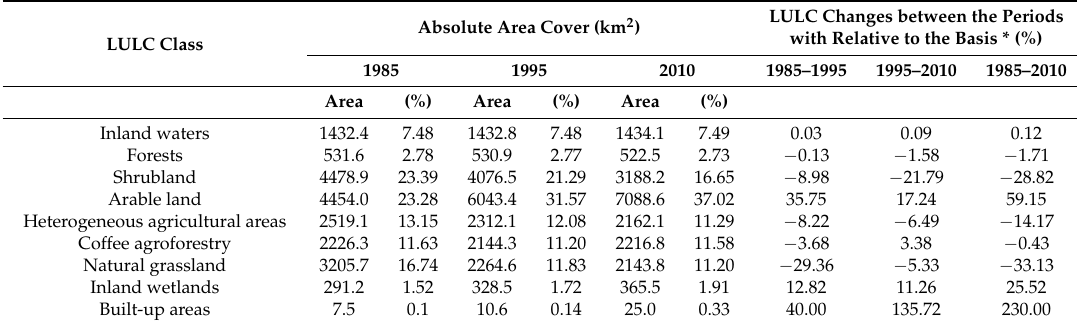
Table 4. LULC changes of Abaya-Chamo Basin (ACB), Southern Ethiopia in 1985, 1995, and 2010. LULC Changes between the Periods Absolute Area Cover (km 2 ) with Relative to the Basis * (%) LULC Class 1985 1995